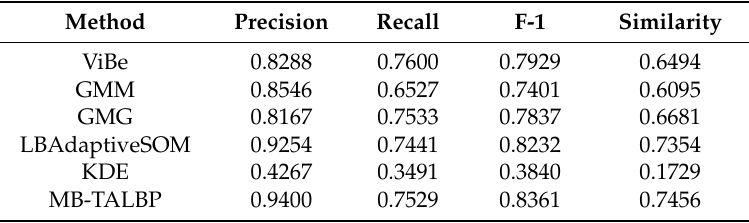
Table 4. Comparison of indexes of “One rainy hour”.